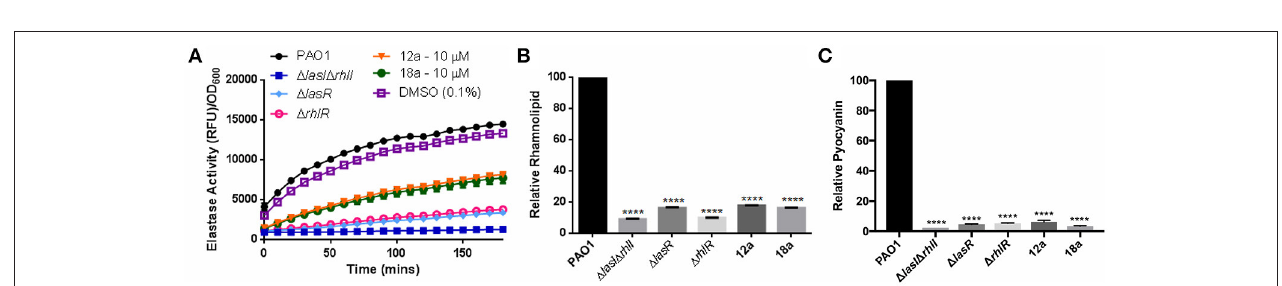
FIGURE 3 | QSI inhibition of compounds 12a and 18a on PAO1 1 lasR rhlA-gfp (A) and pqsA-gfp (B) . DMSO 0.1% was used as solvent control. All experiments were done in triplicate manner (technical and biological replicates), only representative data are shown.